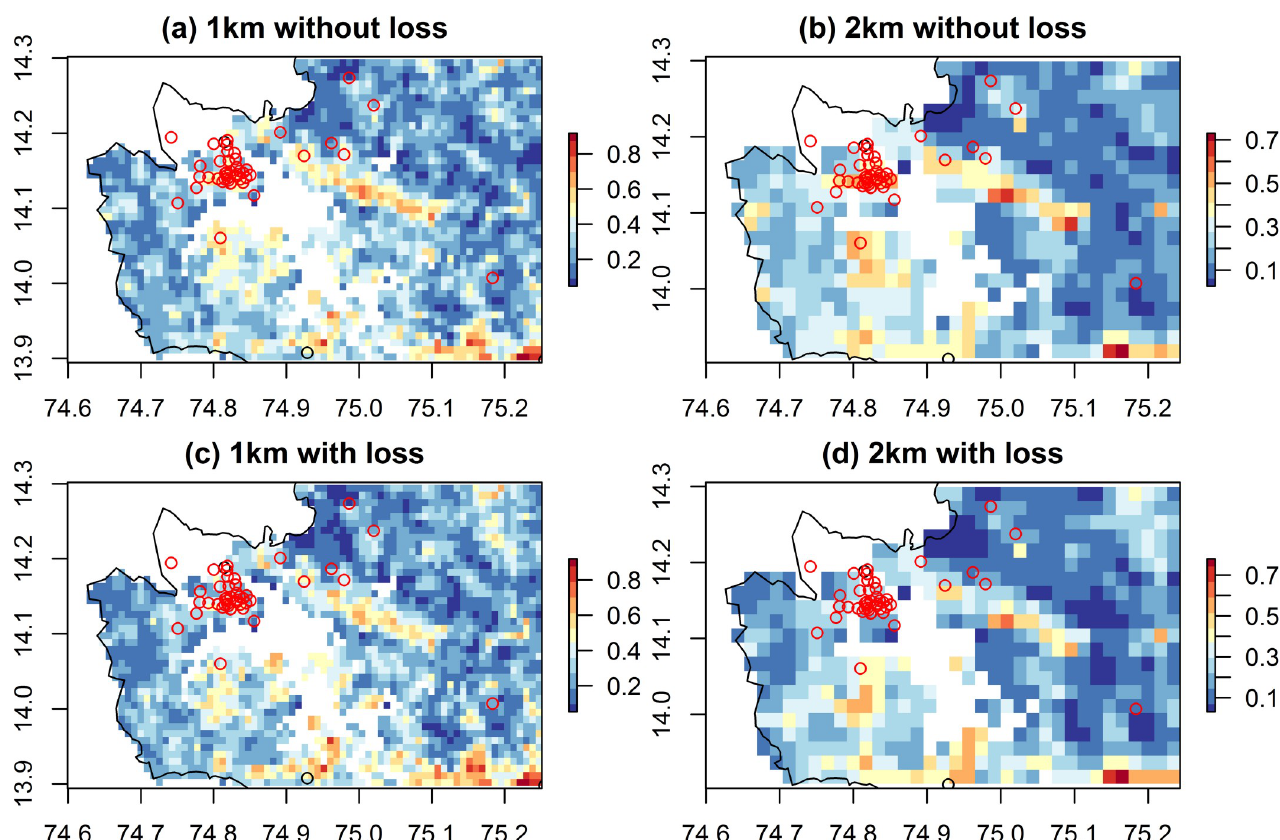
Fig 7. Predicted probability of presence of KFD from Boosted Regression Tree models for the 2019 outbreak region in Sagara taluk. Models are at a 1 km (left hand panel) and 2 km resolution (right hand panel), with area of forest loss included in the predictors (bottom panel) and without (top panel). The outbreak locations from the 2018 to 2019 season (open red circles), occur in areas of medium to high probability of presence (yellow to red) in all models. White areas have missing environmental data because they contain water-bodies or are outside of Shivamogga district. These raster maps are not under copyright since they are a product of this study. The administrative boundary dataset is from HindudstanTimesLabs (https://github.com/HindustanTimesLabs/shapefiles/ ), reproduced under the MIT License. Human case data are from Department of Health and Family Welfare Services, Government of Karnataka.